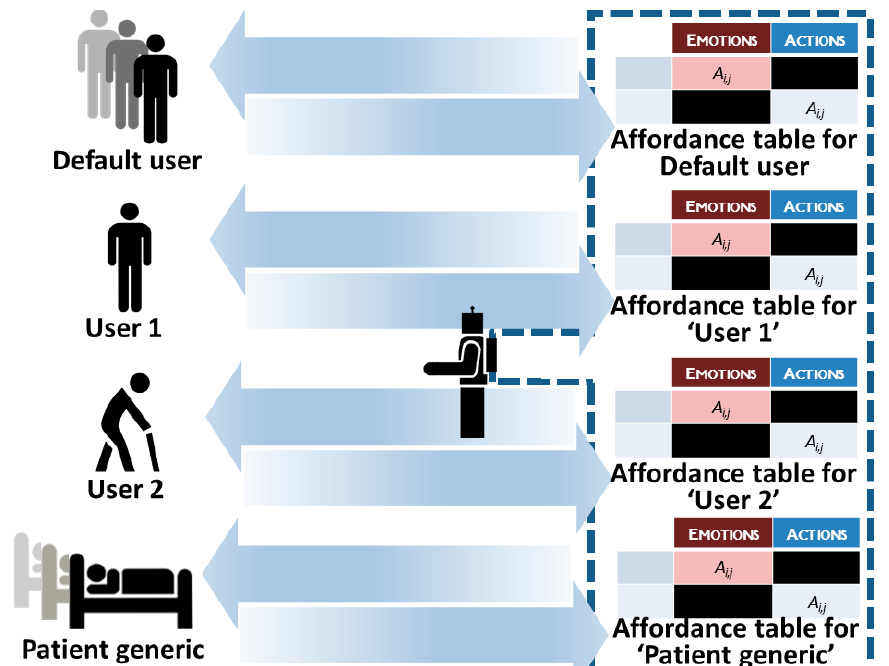
Figure 4. Concept of customised affordance evaluation tables.